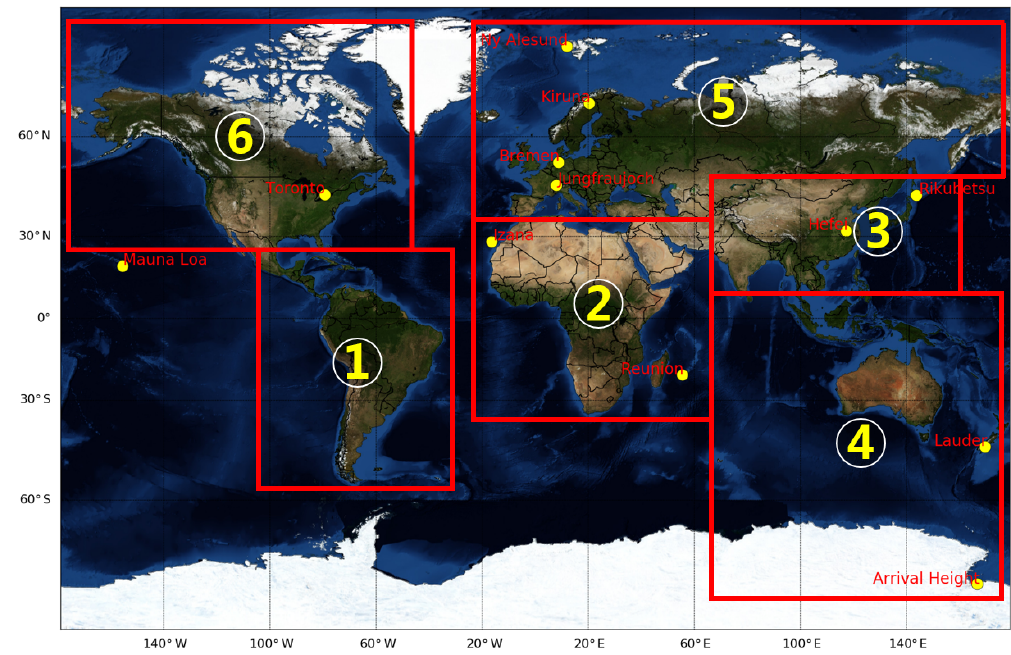
Figure 1. The location of Hefei site alongside those of the NDACC FTIR stations (yellow dots) that are selected for comparison. Geographical source regions used in the standard GEOS-Chem tagged CO simulation are also shown. See Table 3 for latitude and longitude definitions.